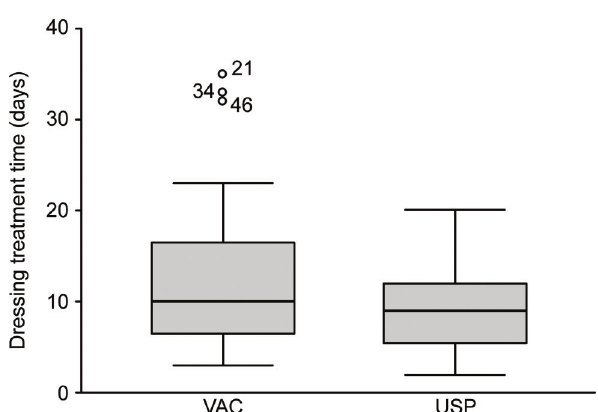
Figure 2 - Time necessary to achieve a ‘‘ ready for the surgery ’’ condition